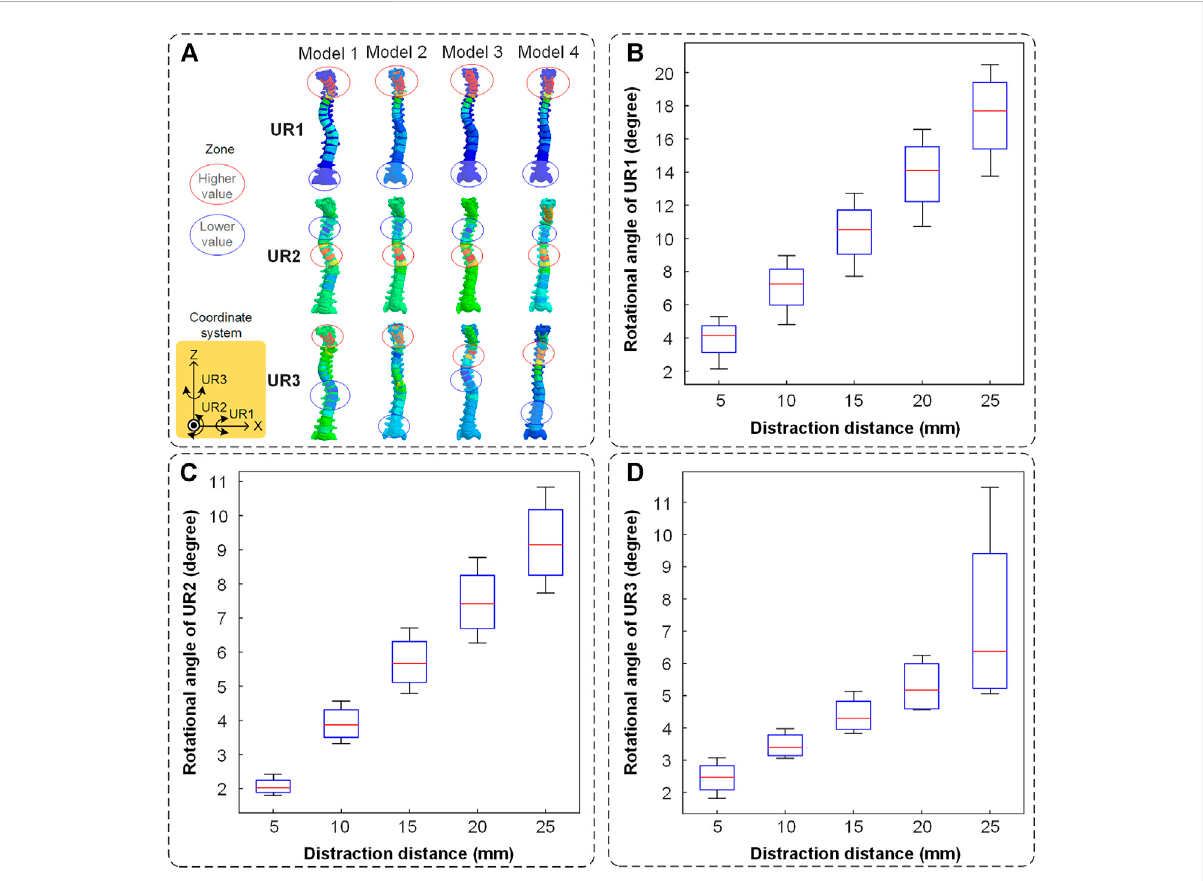
FIGURE 6 The spinal rotation inthree directions. (A) The nephogram of fi nite element results (when thedistraction distance is25 mm).The higher valueis labeled in a red circle and the lower value is labeled in a blue circle. (B) The spinal rotation in the UR1 direction. (C) The spinal rotation in the UR2 direction. (D) The spinal rotation in the UR3